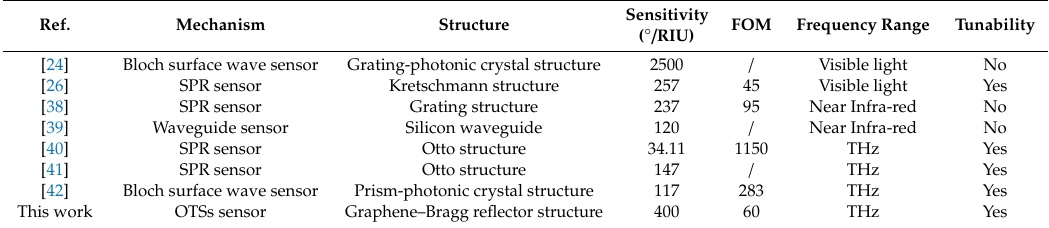
Table 1. Comparison between di ff erent refractive index sensing methods.